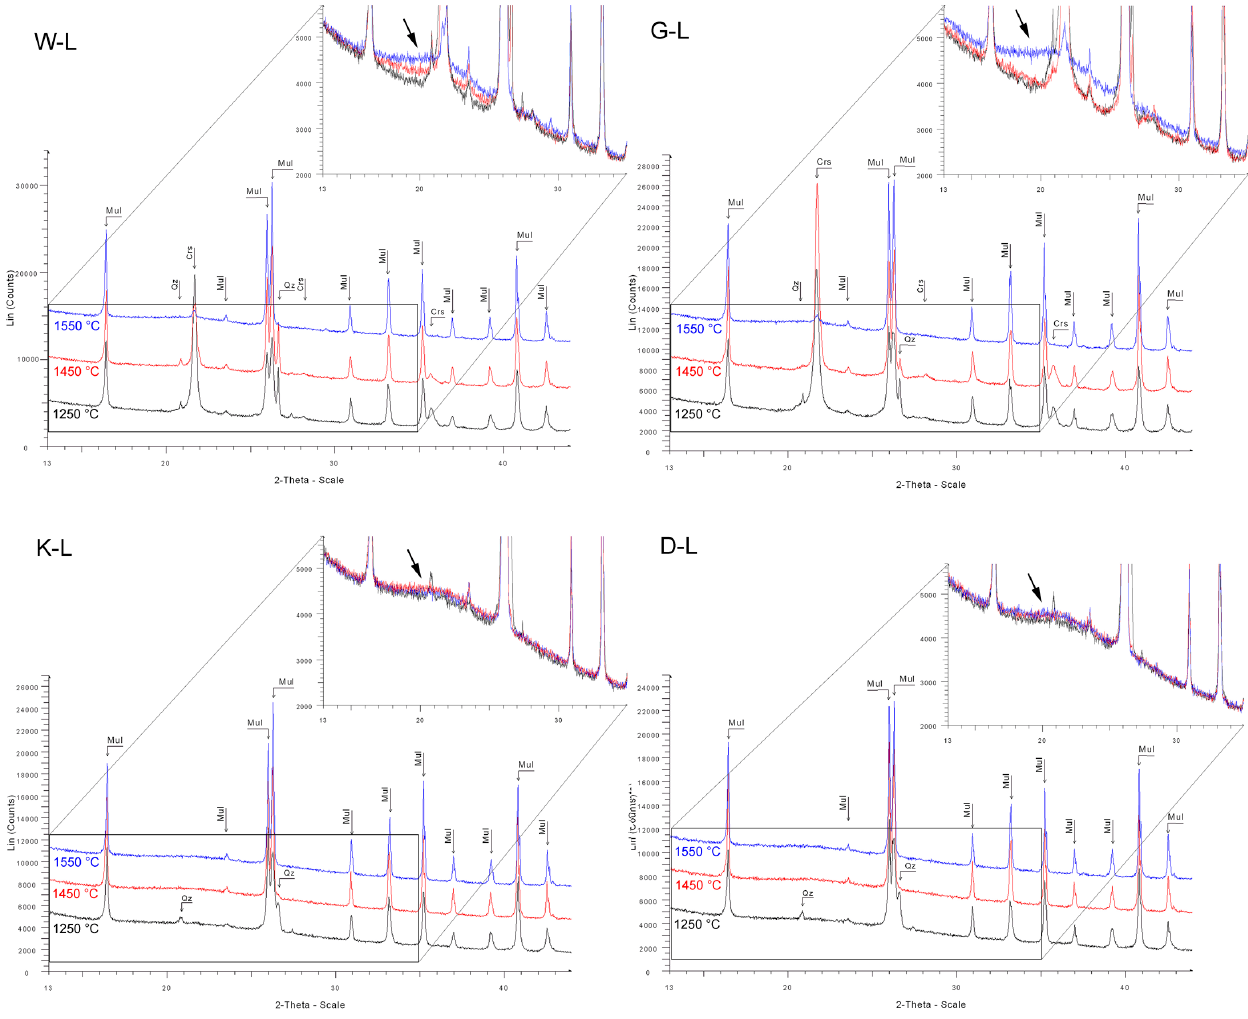
Figure A7. Diffractograms of samples prepared in laboratory conditions; zoomed images in upper right corners show comparisons of diffused background intensity, which corresponds to the contents of X-ray amorphous phase.